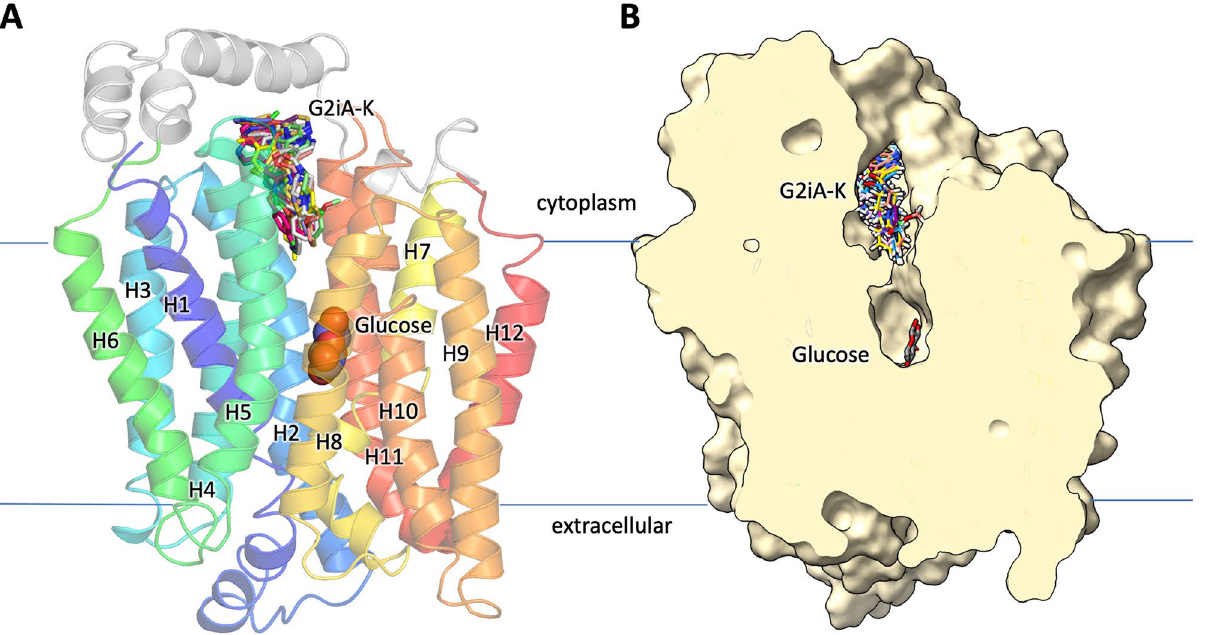
Figure 1. GLUT2 inward-facing conformation model and selected ligands from the virtual screening. The inward-facing conformation of GLUT2 showing the glucose binding site (glucose shown in sphere representation) and several ligands from the virtual screening (Table 1) bound above the glucose binding site (ligands shown as stick representation, in different colors). The homology model was generated based on the GLUT1 crystal structure (PDB ID: 4PYP). ( A ) GLUT2 model in ribbon diagram, with the transmembrane helices color-coded from blue (first transmembrane helix, H1) to red (last transmembrane helix, H12) (see also Fig. 4L). ( B ) Central slice through the GLUT2 isosurface showing the substrate cavity containing the glucose binding site and docked ligands. The figure was generated with ChimeraX Version 1.2 (https:// www. rbvi. ucsf. edu/ chime rax/) and PyMOL Version 2.3.0 (https:// pymol.